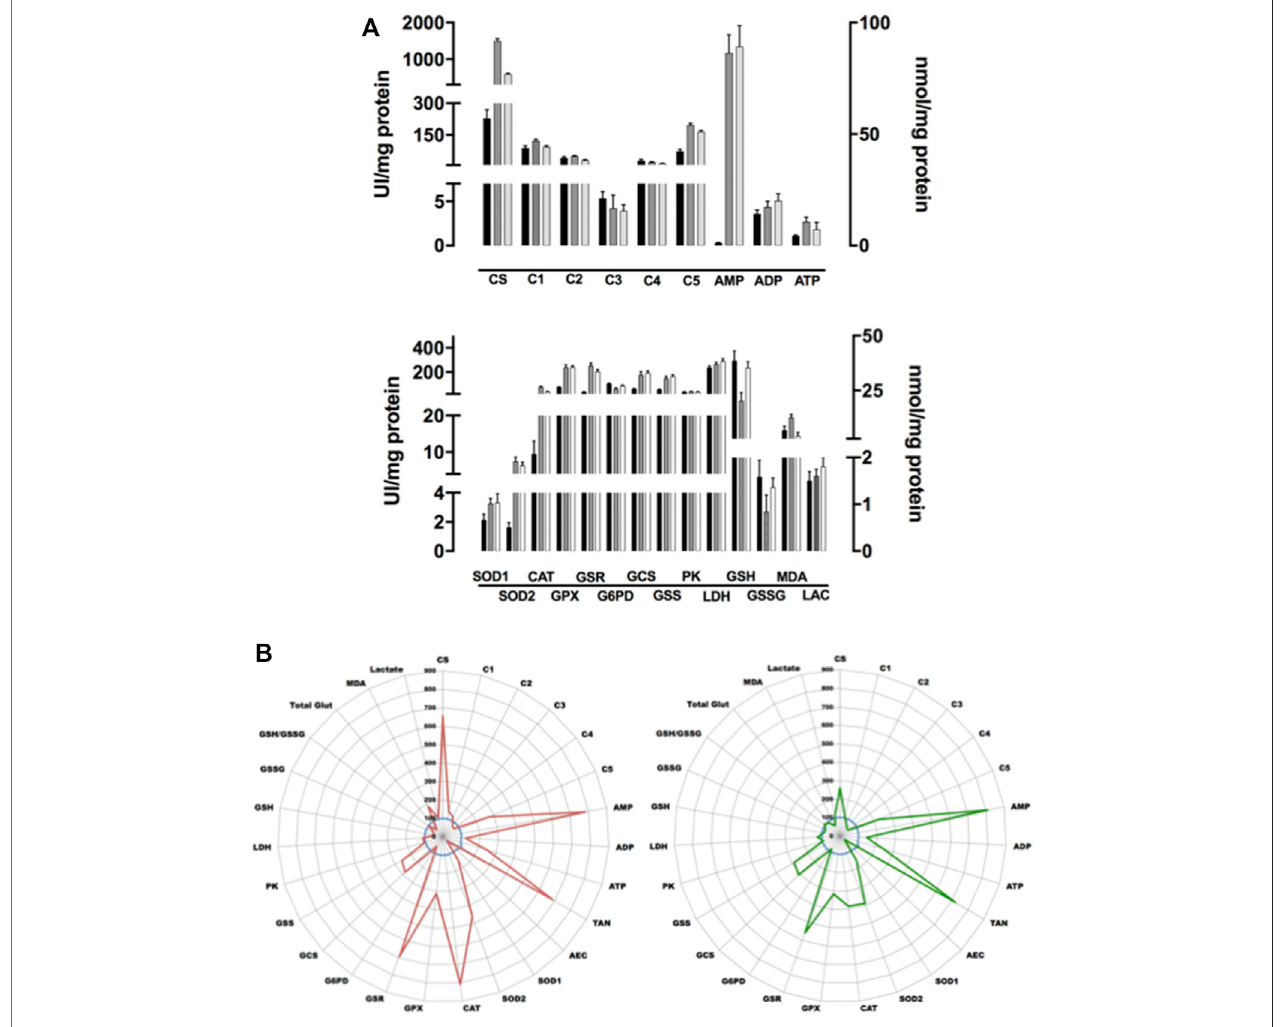
FIGURE 4 | Comparative analysis of three prostate cell lines. (A) : Figure4A depicts results ofthe three cell lines(mean of fi ve different experiments) in conventional box plots showing mean and standard deviation. PNT1A cells are in black bars, VCaP in grey and PC3 in white ones. Upper fi gure: AMP, ADP, and ATP are plot to right axiswhileallotherparametersrefertoleftone.Lower fi gure:GSH,GSSG,MDA,andLACareplottorightaxiswhileallotherparametersrefertoleftone. (B) :Radargraph depicting the metabolic results of the three cell lines (prostate PNT1A, blue line, normal control as 100%; VCaP cells, red line and PC3 cells, green line). Each point represents the mean of 5 independent experiments. All enzyme results are expressed in UI/g protein, lactate, glutathione and MDA respectively in mmol, μ mol, nmol/g protein. The scale on the radar graph represents % of variations versus control. TAN: total adenylate (ATP + ADP + AMP), AEC: adenylate energy charge (ATP+1/